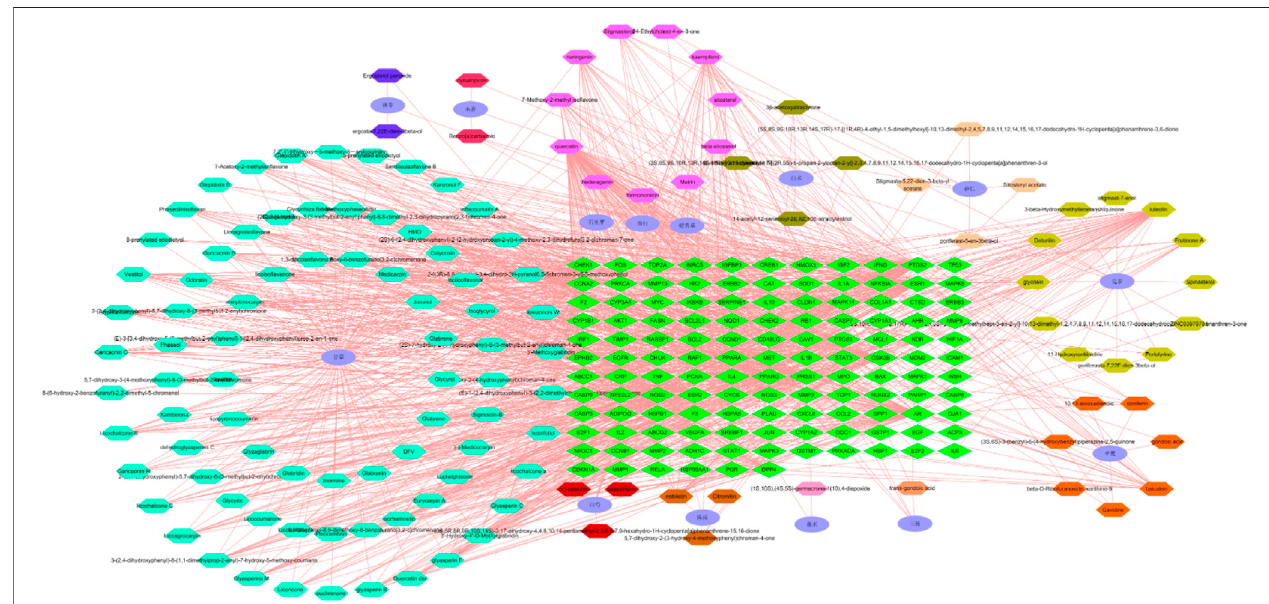
FIGURE 2 | Active ingredient – active target network of Guishao-Liujun decoction.